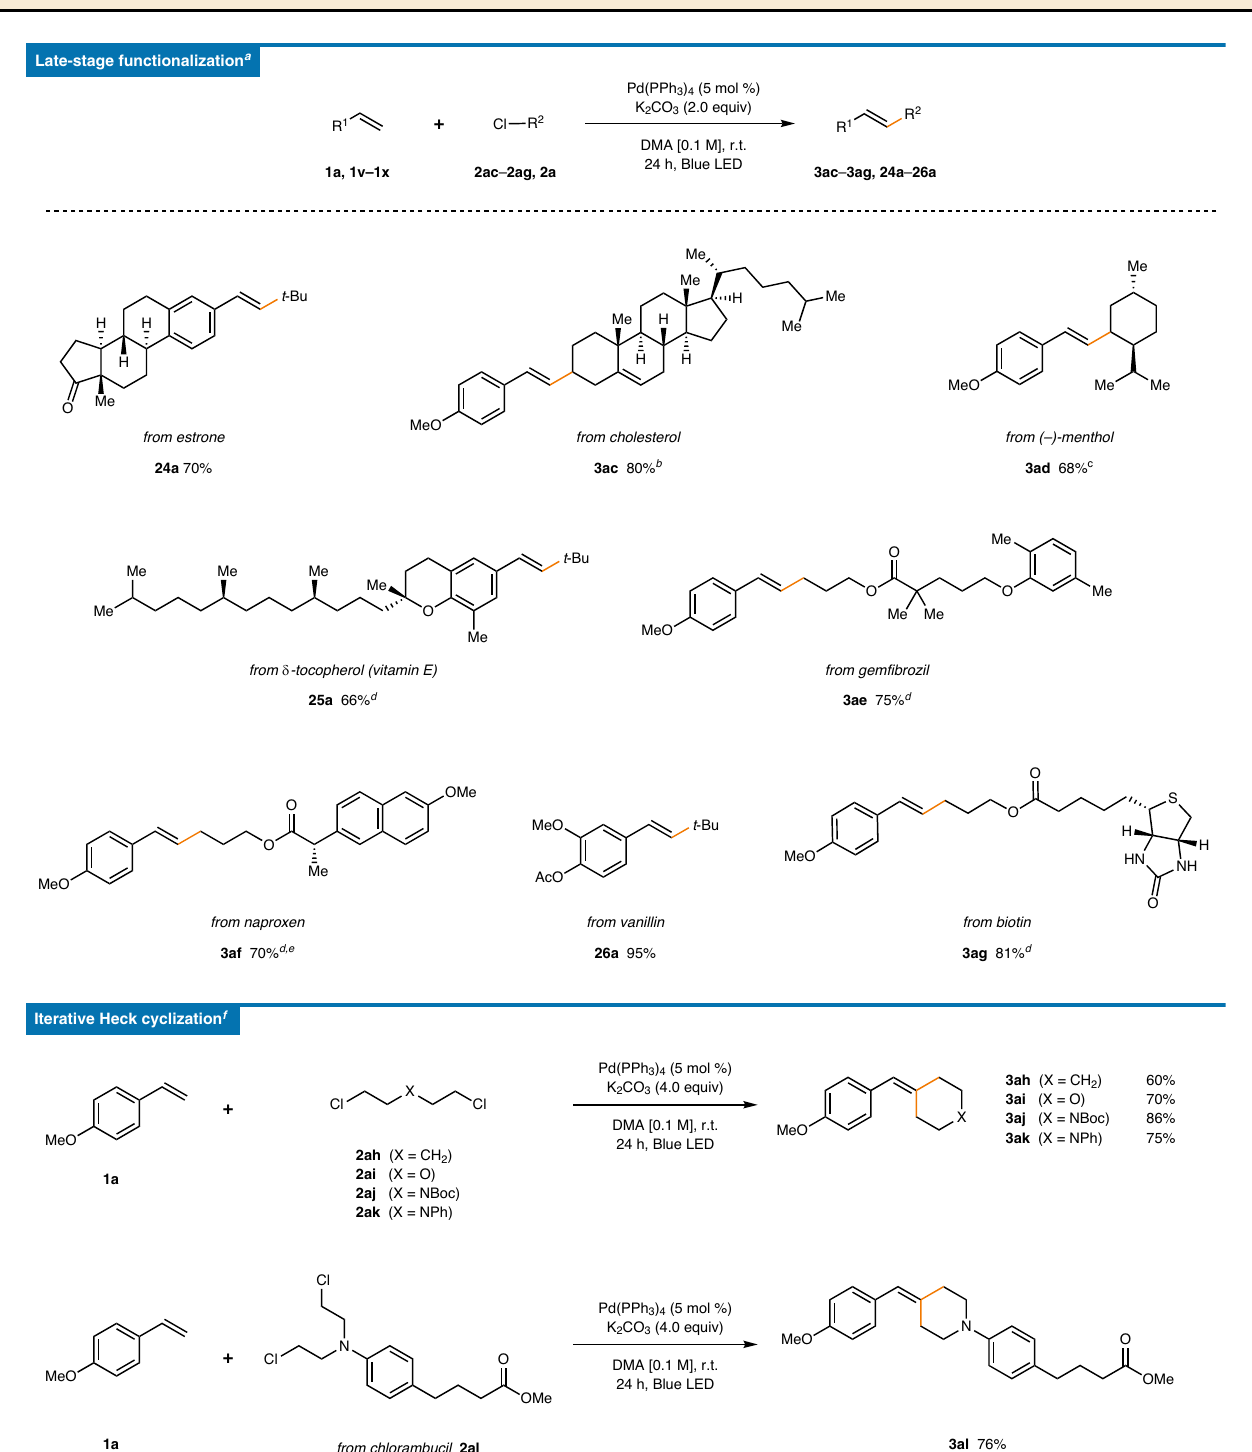
Table. 4 Synthetic applications a